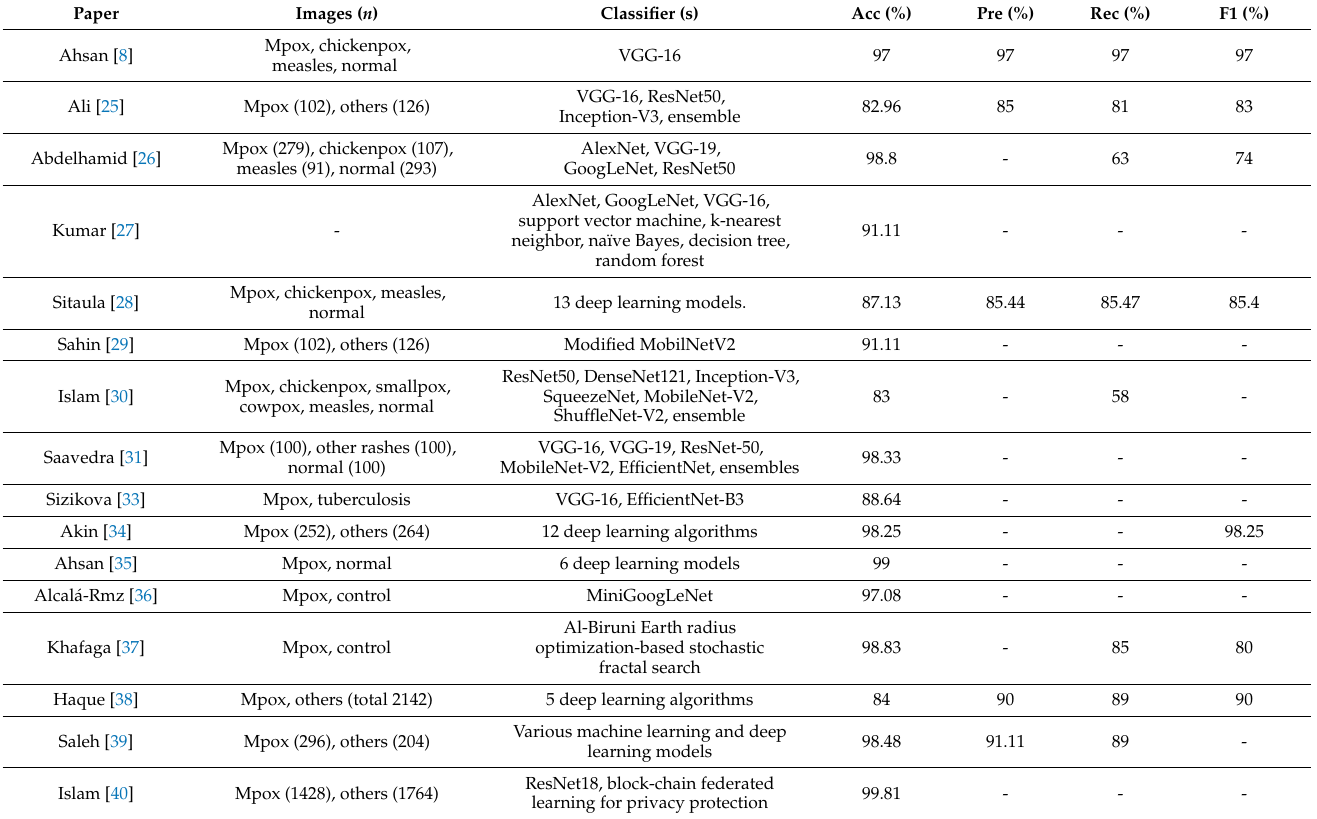
Table 1. Summary of published artificial intelligence-based mpox classification models using skin